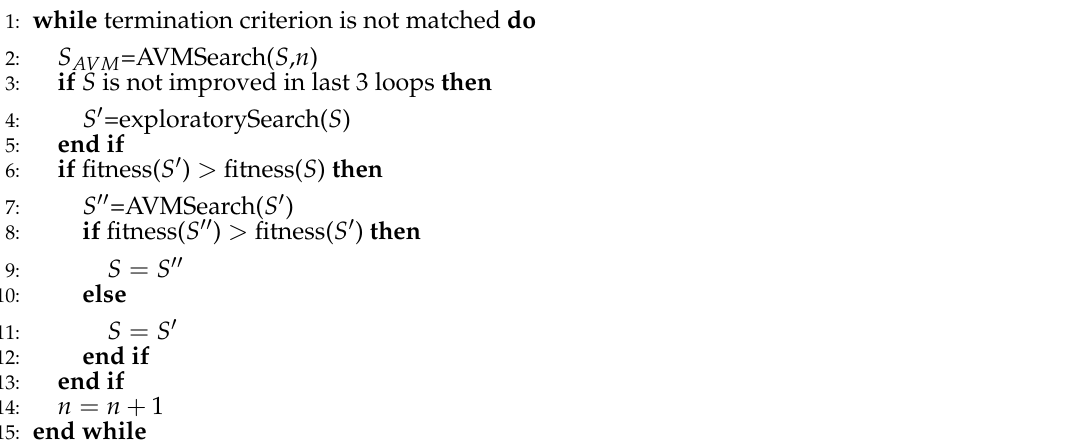
Algorithm 1 The search-based test case prioritization using the alternating variable method